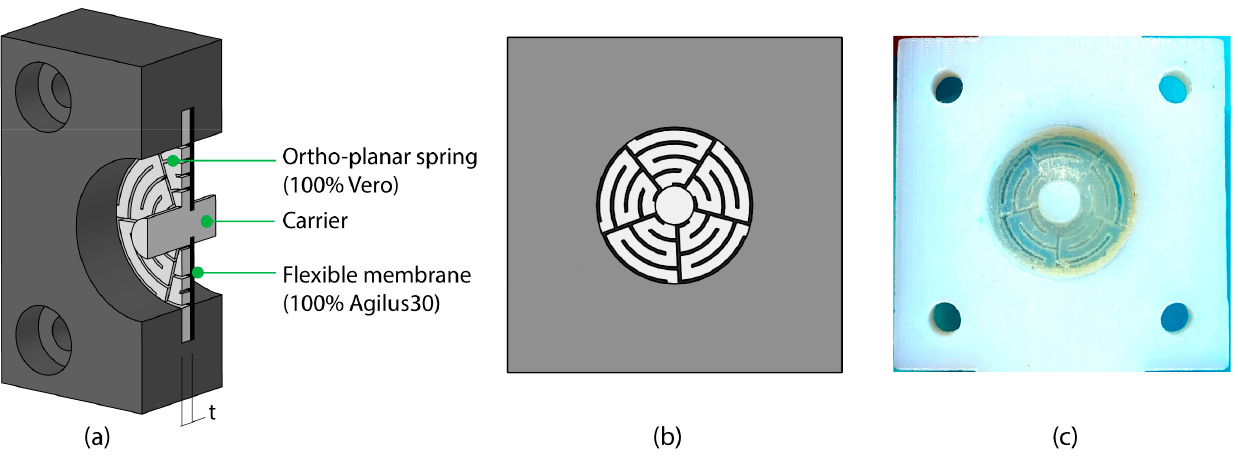
Figure 10. Design of the spring-reinforced diaphragms. ( a ) 3D model showing the cross-section of the prototype, with a flexible membrane printed in 100% Agilus30 and on top an ortho-planar spring printed in 100% Vero. ( b ) Top view of the spring design. ( c ) Photograph showing the printed pro- totype.